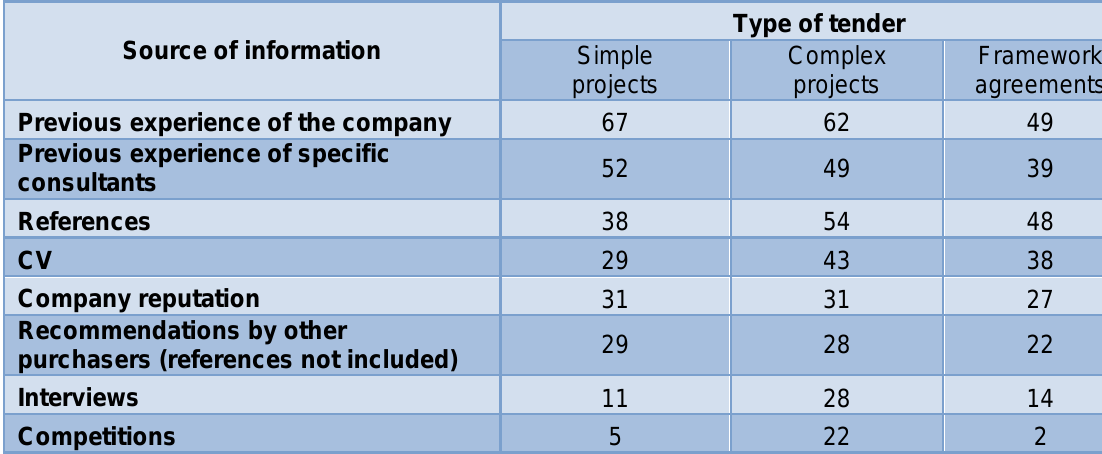
Table 4 Municipalities that use sources of information for tender evaluation (percentage of all